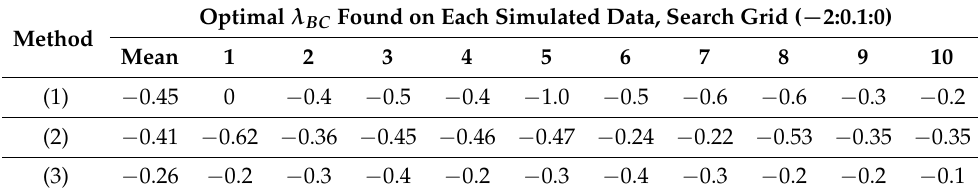
Table 2. Optimal λ BC grid search on simulated data (128 × 420; − 2:0.1:0).